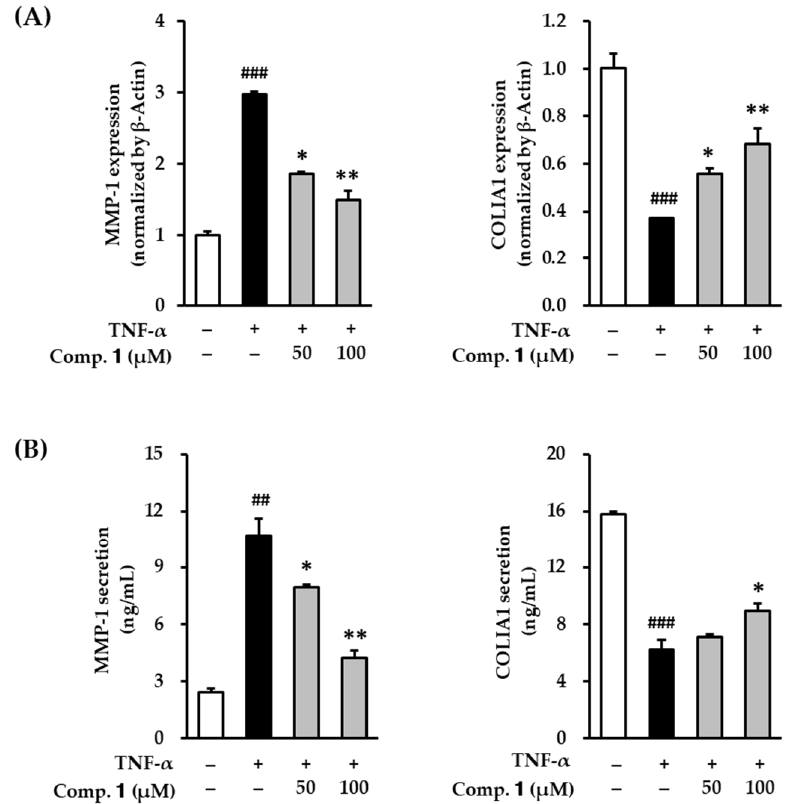
Figure 4. Effects of 1,3-dihydroxy-2,8-dimethoxy-6-methylanthraquinone ( 1 ) on MMP-1 and COLIA1 mRNA and protein expression in TNF- α -stimulated HDFs. HDFs were untreated or exposed to TNF- α , followed by treated with 1 for 4 h or 12 h. The levels of mRNA and protein expression were determined using qRT-PCR and ELISA. ( A ) Relative mRNA expression levels of MMP-1 and COLIA1. ( B ) Protein expression of MMP-1 and COLIA1. The data are presented as mean ± SEM from three independent experiments. ## p < 0.01 and ### p < 0.001 difference compared to